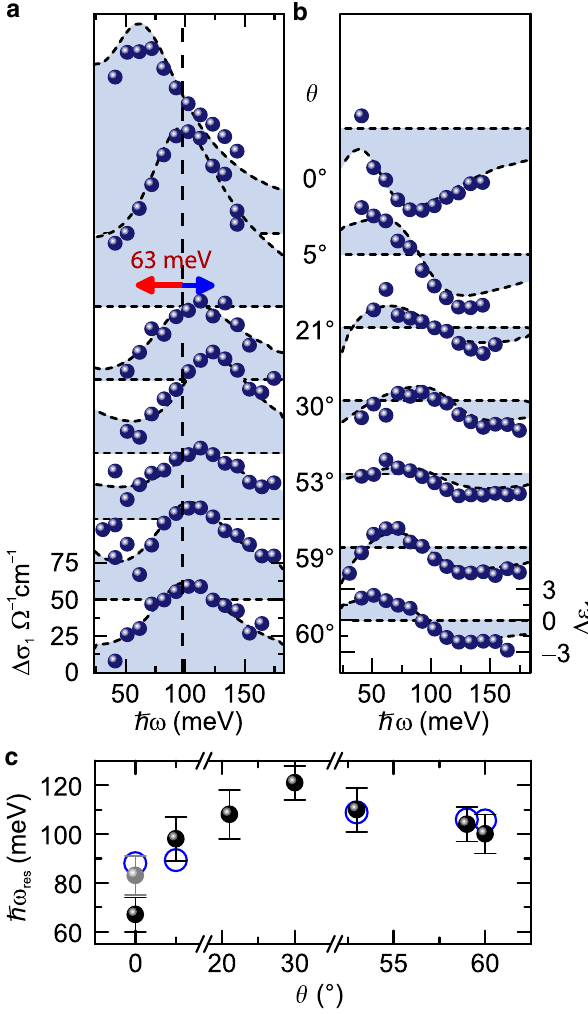
Fig. 2 Evolution of the 1 s – 2 p resonance with interlayer twist angle. a , b Pump-induced changes of the real parts of the optical conductivity Δ σ 1 ( a ) and the dielectric function Δ ε 1 ( b ) for a fi xed pump-probe delay time t = 5.1 ps as a function of the photon energy for samples with different pp twist angles θ . The blue spheres represent the dielectric response measured for the photoexcited WSe 2 BLs (pump fl uence Φ = 27 µ J cm − 2 ; sample temperature, 5 K). The blue shaded areas indicate the fi ts to the experimental data by a phenomenological model (see Methods). The dashed line and the blue/red arrow indicate the blue/red shift of the intraexcitonic 1 s – 2 p resonance energy for increasing misalignment angle with respect to the 2H stacking. c Intraexcitonic 1 s – 2 p transition energy ħ ω res (black spheres) extracted from the data in a , b and derived from the microscopic theory (blue circles) as function of the twist angle θ . For θ = 21° and θ = 30°, microscopic calculations of hybrid excitons were not feasible. In the case of θ = 0°, the intraexcitonic resonance exhibits a strong dependence on the exciton density (see Fig. 4c and Supplementary Note 4). The gray sphere indicates the resonance energy as obtained for a pump fl uence of Φ = 7 µ J cm − 2 , yielding the best agreement with the microscopic theory. The error bars represent the 95% con fi dence interval of the fi tting